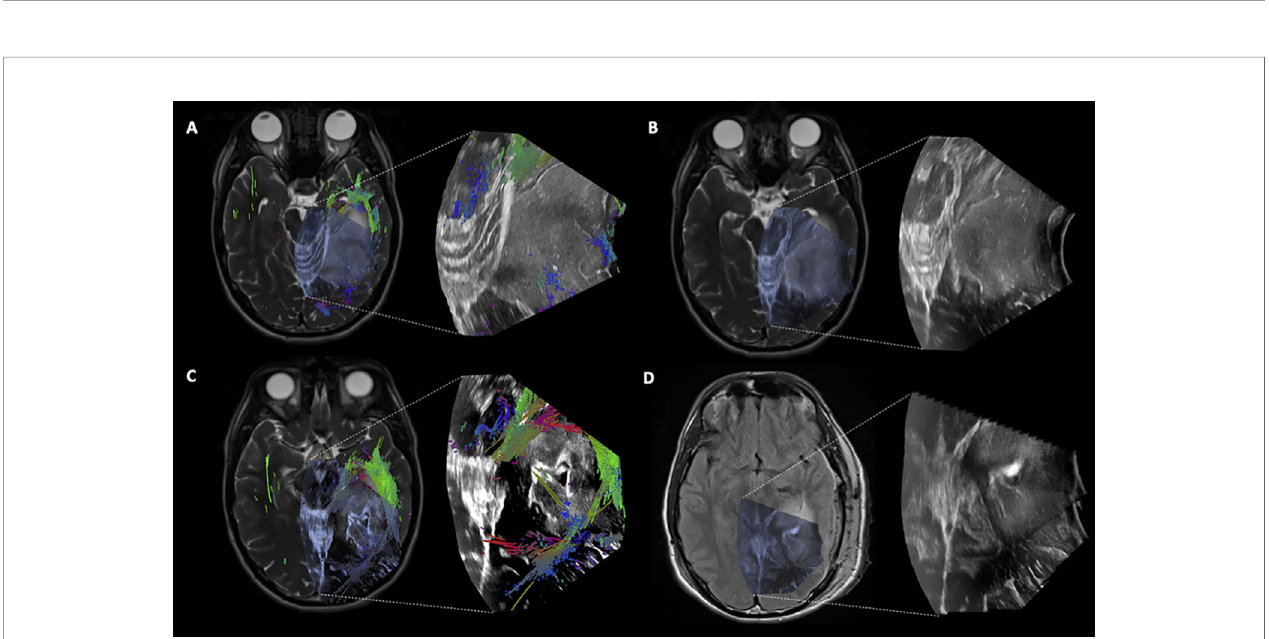
FIGURE 4 | Case 2 Post hoc manually aligned preoperative axial T2-weighted imaging with (A) iUS-1, (B) iUS-2, (C) iUS-3 with multiple tracts around and inside the tumor, and (D) iMRI axial T2-FLAIR imaging manually aligned with iUS-3 without the overlaid tracts. Notice on C the presence of tracts running through the tumor. On D, it is possible to notice the presence of residual tumor in the posterolateral margin as well as posteriorly along the medial margin in the vicinity of the coursing tracts through the tumor.